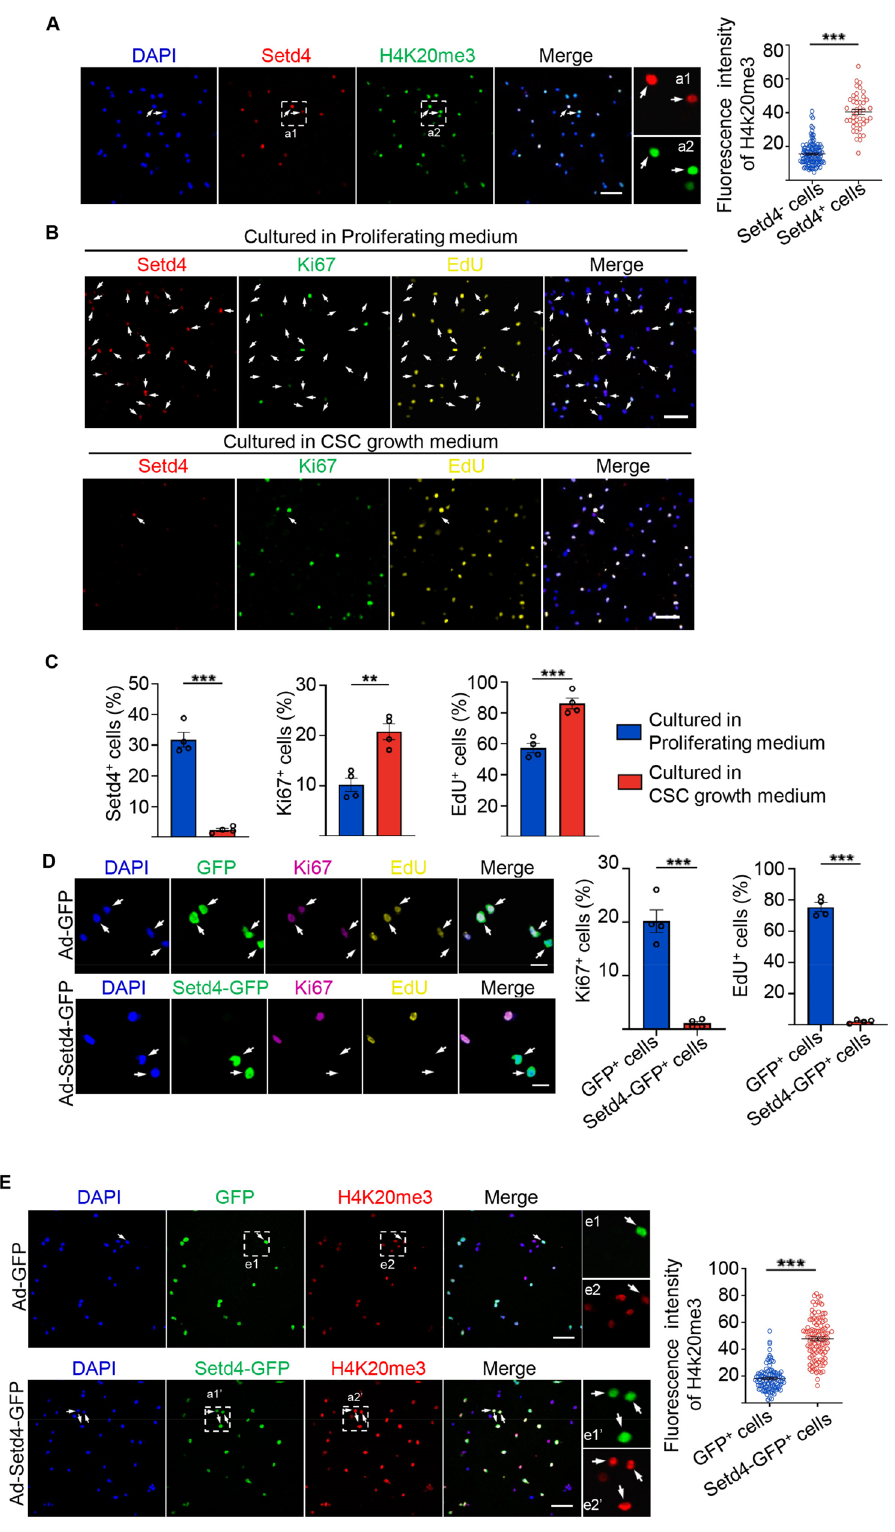
Figure 2. Setd4 regulates the quiescence of c-Kit + cells by facilitating heterochromatin formation. ( A ) Identification and quantification for FACS-sorted c-Kit + cells with high levels of Setd4 and H4K20me3. Scale bar = 50 μm. n = 173 cells from 3 mice. ( B , C ) Representative immunofluorescence and quantification for c-Kit + cells cultured in proliferating medium or cardiac stem cell growth medium with Setd4 incorporation of EdU and Ki67. Scale bar = 50 μm. n = 4 mice. ( D , E ) Representative immunofluorescence and quantification for activated c-Kit + cells affected by Ad-GFP and Ad-Setd4 with incorporation of EdU, Ki67 ( D ), n = 4 mice and H4K20me3 ( E ), n = 105 cells from 3 mice. Scale bars = 10 μm. Nuclei were stained with DAPI. All data are represented as mean ± SEM. Comparison of independent variables was conducted by two- tailed unpaired Student’s t test. ** p < 0.01, *** p <